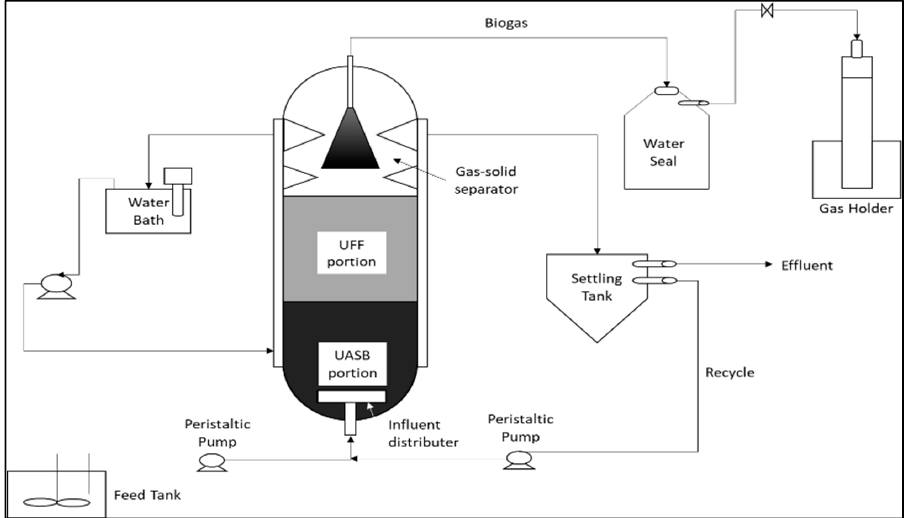
Figure 8. Schematic diagram of the UASFF reactor. Adapted with permission from ref. [54]. Copyright 2006 Elsevier.